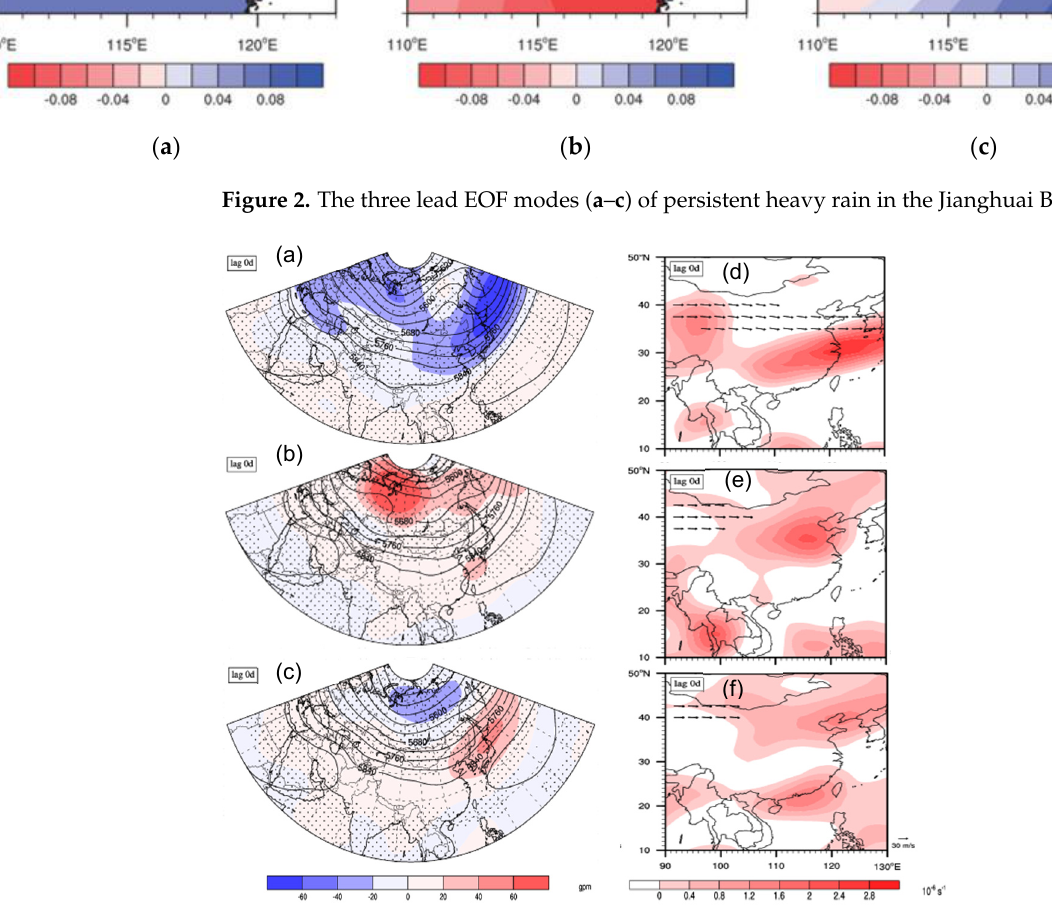
Figure 3. Composite heights at 500 hPa and zonal wind at 200 hPa for Mode1 ( a , d ), Mode 2 ( b , e ), Mode 3 ( c , f ); contour for height, color for height anomaly in ( a – c ), the dotted denote the t -test exceeding confidence level of 0.1 in ( a – c ). Arrows for the mean u ≥ 30 m · s − 1 in ( d – f ), color for the anomalous divergence in ( d – f ), unit: 10 − 6 ·s − 1 ).